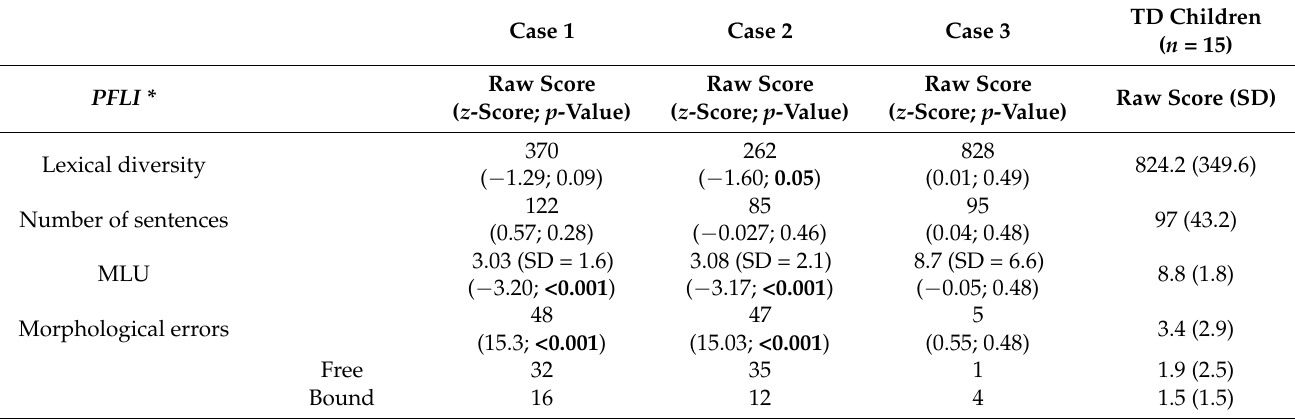
Table 3. Qualitative analysis of the morpho-syntactic production elicited by PFLI and statistical comparisons between the three deaf children and TD children. Raw scores, z -scores and p -values of the lexical diversity, number of sentences, MLU, and morphological errors are